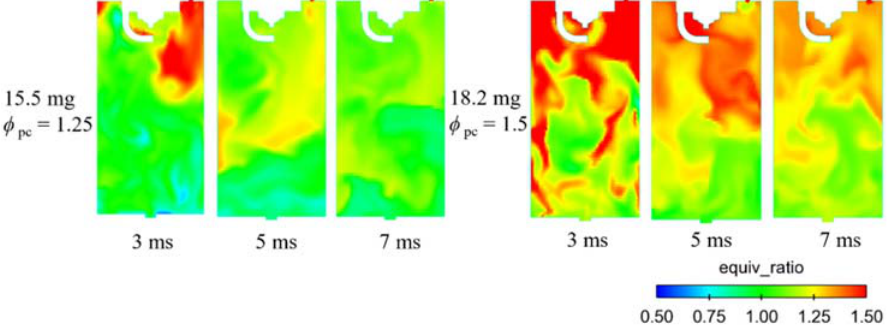
Figure 9. Distribution of equivalence ratio for different prechamber global equivalence ratios.